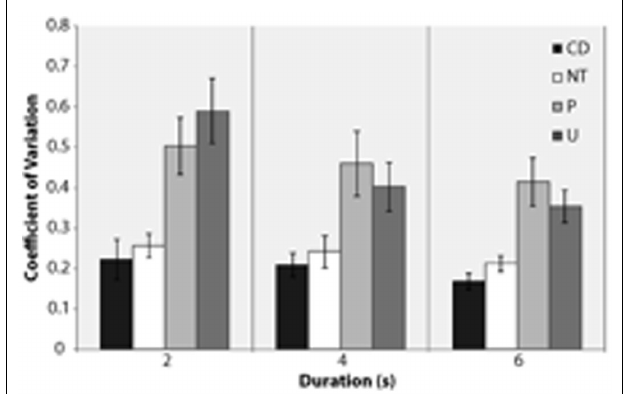
FIGURE 2 | Coefficient of variation (averaged across participants) for each standard duration (2, 4, 6s) in content-deprived (CD) and content-bearing [neutral (NT), pleasant (P), unpleasant (U)] conditions. (Note error bars denote SR of the